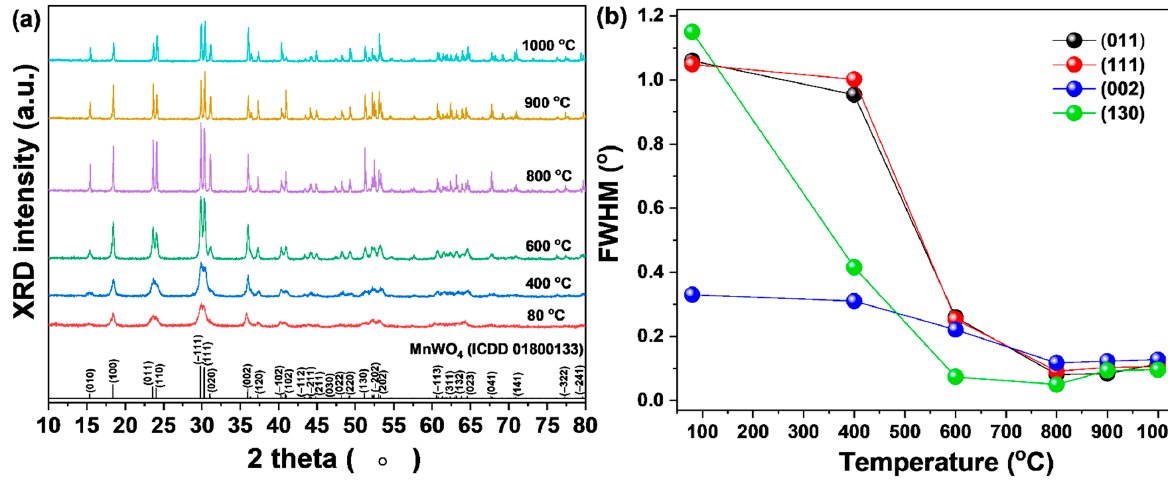
Figure 2. ( a ) XRD patterns of MnWO 4 and ( b ) FWHM of main peaks according to various sintering temperatures.